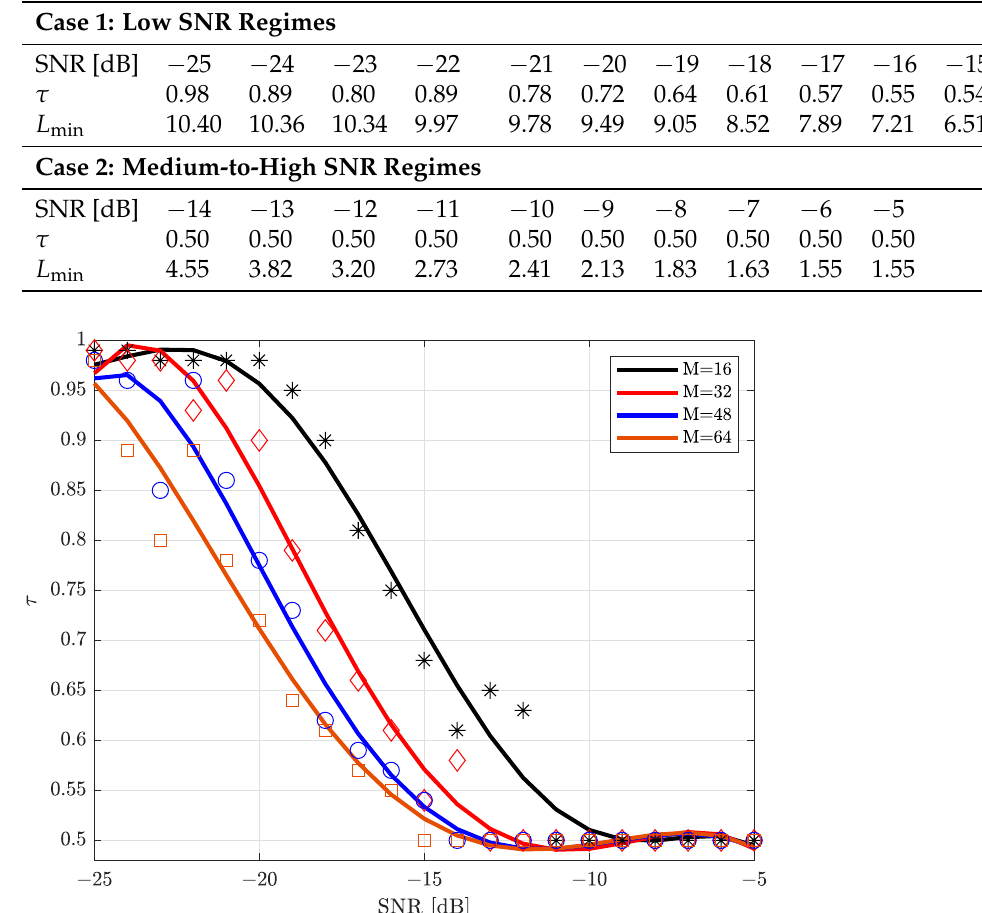
Figure 3. Quantization threshold, τ , versus SNR [dB] for different number of